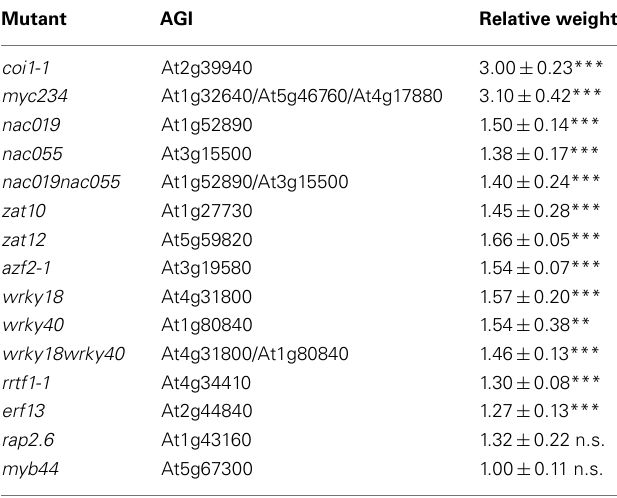
Table 1 | Insect performance on transcription factor mutants.